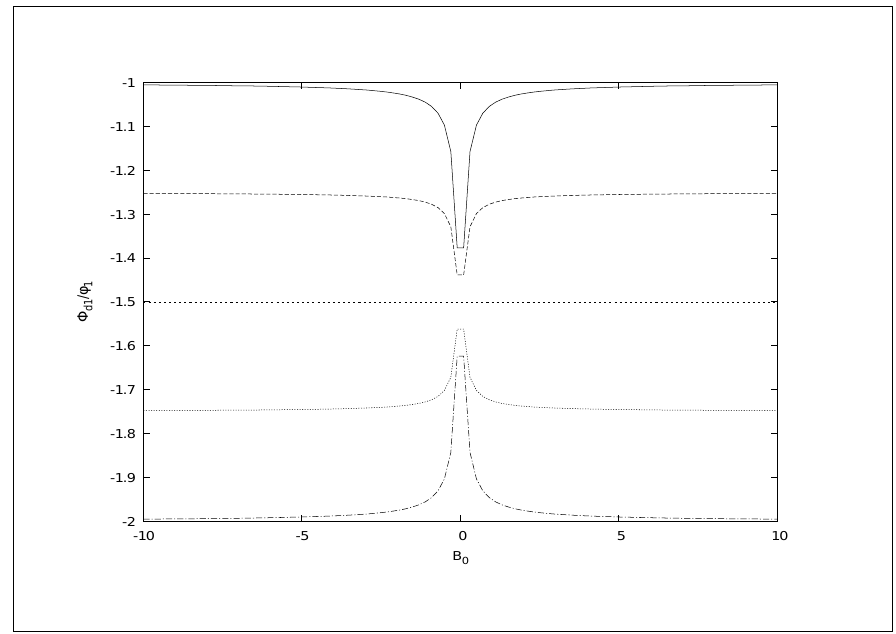
Figure 5. Variation of τ -independent part of Φ d 1 for entangled states as a function of gravitational coupling in units of eV with m e = 0.01 eV, m µ = 0.1 eV and m µ e = 0.05 eV, and φ 1 = φ 2 = β . From top to bottom, lines are for α = 0, π /6, π /4, π /3 and π